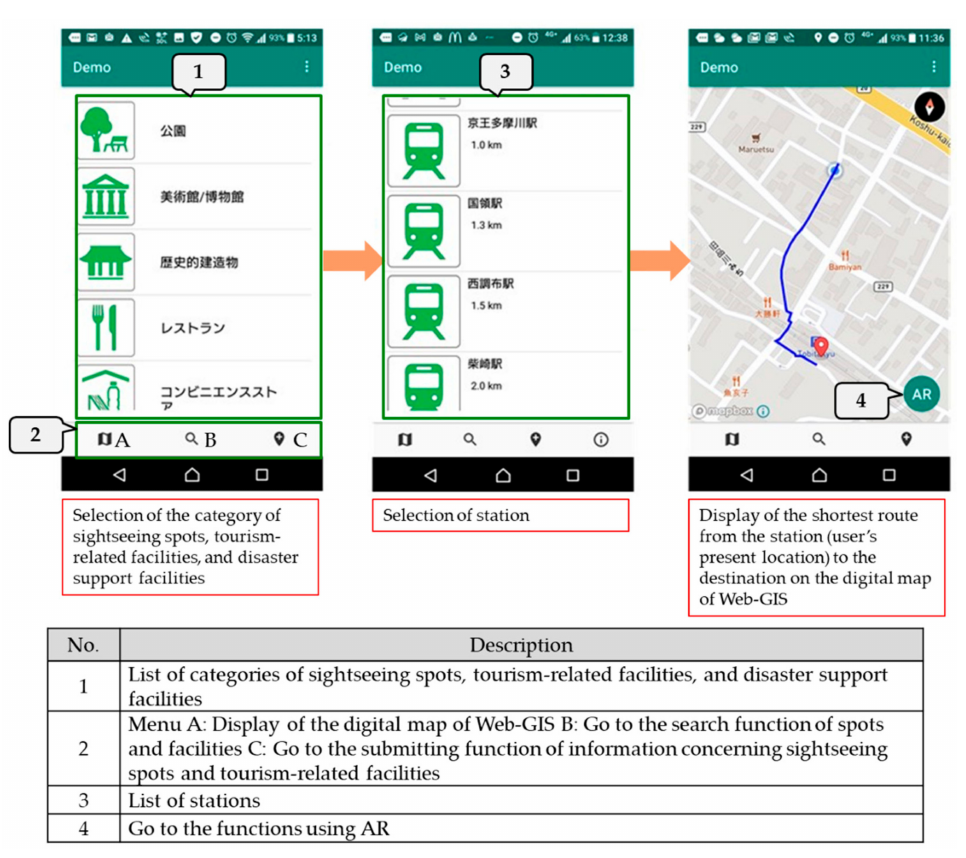
Figure 4. Screen for the search function of spots and